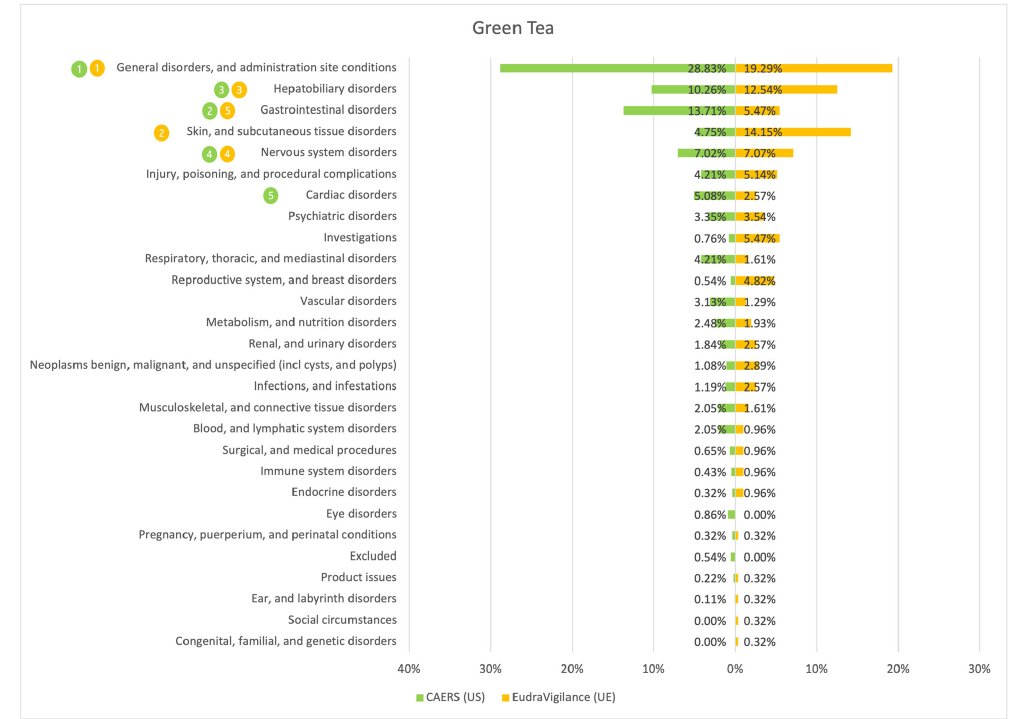
Figure 3. Summary of the frequency of reporting side effects of Green Tea in the US and EU registers. Data marked in green refer to the CAERS (US) database and yellow to the EudraVigilance (UE) database. Numbers 1–5 present the most commonly reported categories of adverse effects in descending order.